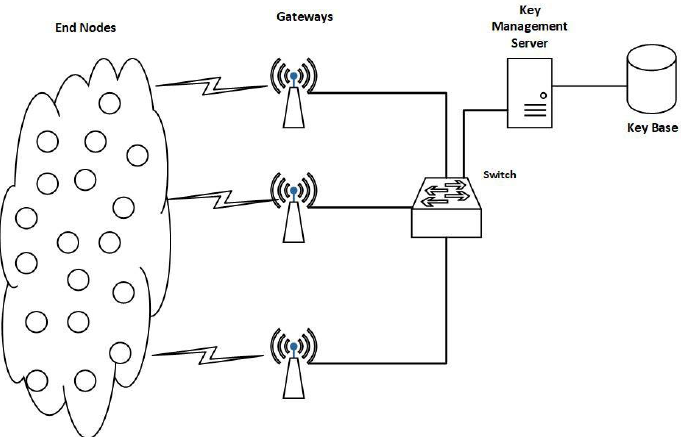
Figure 2. Session Key